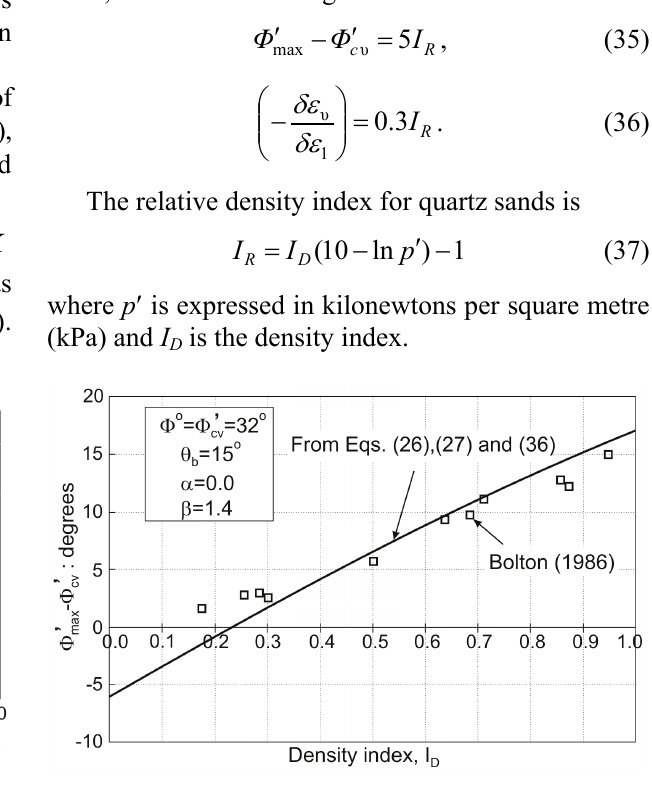
Fig. 5. Influence of density index on (